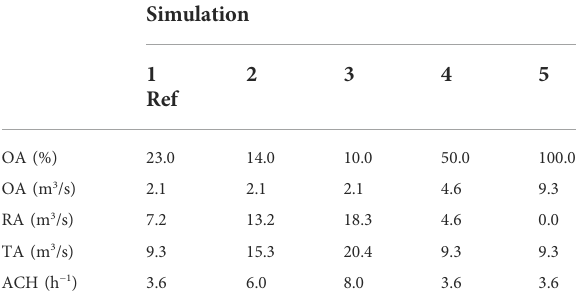
TABLE 2 Numerical simulations of ventilation